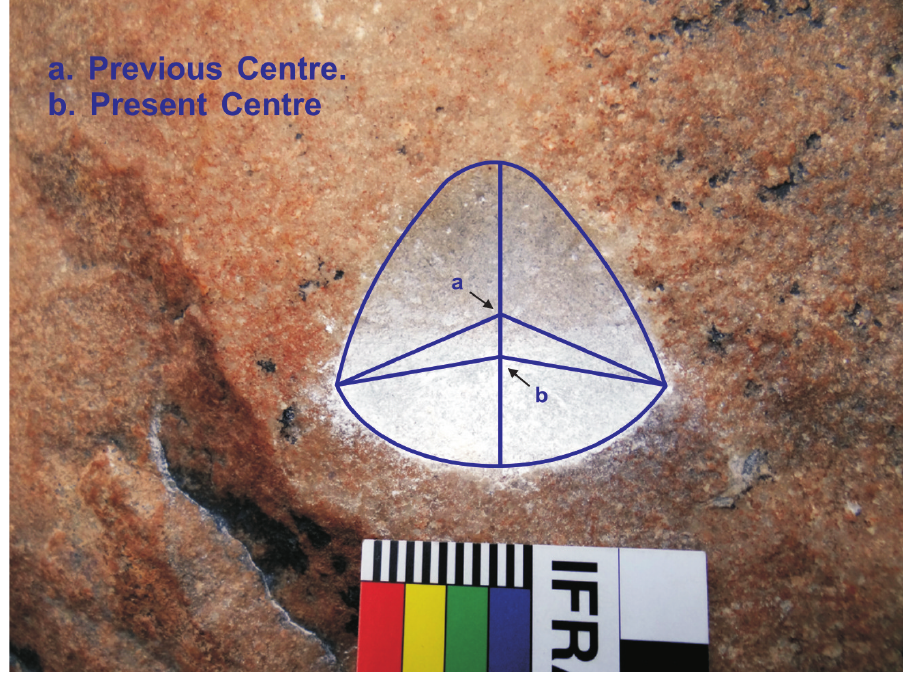
Figure 17. Figure showing the shifting of central point downwards in the roughly triangular